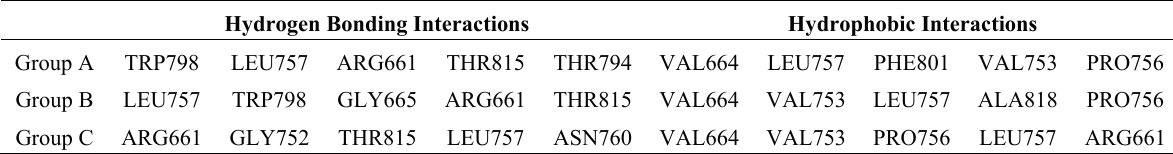
Figure 4. Docking results between FITM, three active NAMs from three groups and 4OR2_A. Table 3. Key interaction and the crucial residues between mGluR1 NAMs and